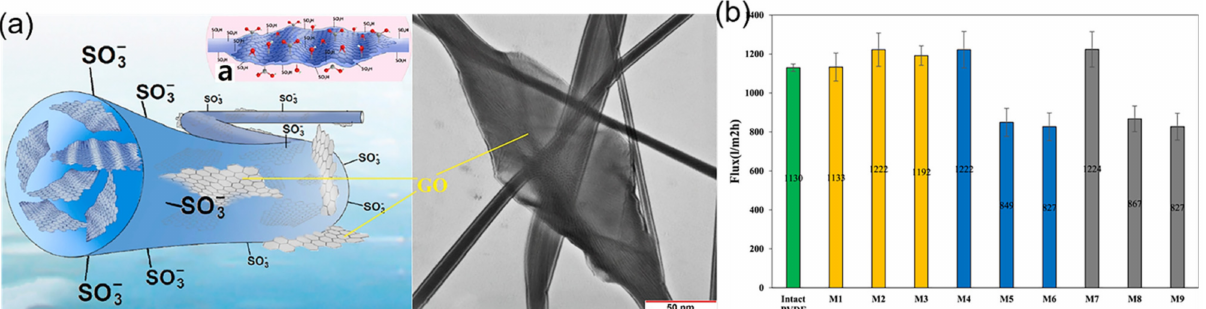
Figure 6. ( a ) Schematic diagrams and TEM images of S-PVDF/PVDF/GO nanofibers; ( b ) Water flux of PVDF ENMs with CNTs in different concentrations. Reprinted with permission from Ref. [101]. 2017,